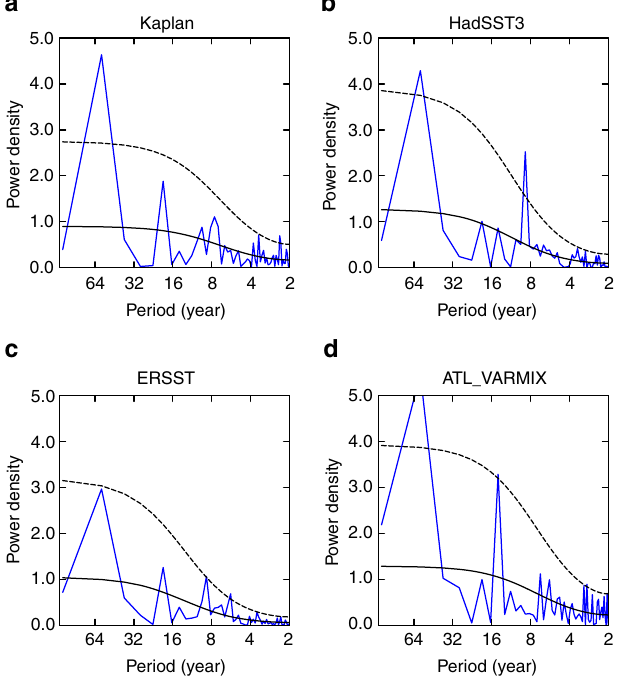
Figure 2 | Power spectral analysis of the western tropical Pacific SST index. ( a – d ) Power spectra of the western tropical Pacific SST index (1900–2013) from both observations (Kaplan, HadSST3 and ERSSTdata sets) and the ATL_VARMIX simulations. The long-term trends in western tropical Pacific SST index are removed before spectral analysis. The solid and dashed black lines in a – d indicate the corresponding red noise spectra (solid black line) and 95% confidence levels for power spectra (dashed black line).